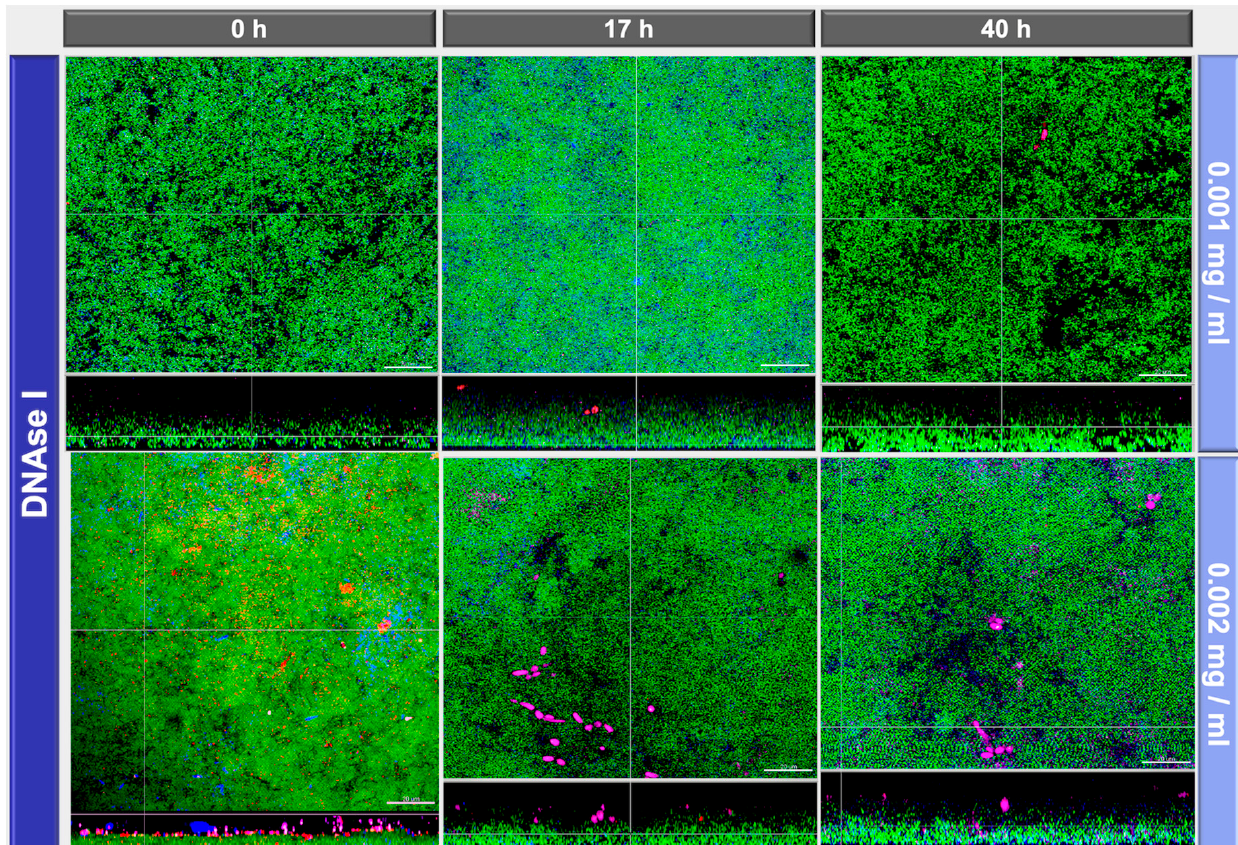
Figure 3. CLSM (confocal laser scanning microscopy) images show the multispecies biofilms after deoxyribonuclease I (DNase I) exposure at two concentrations (0.001 mg/mL, 0.002 mg/mL) and intervals (0 h, 17 h, 40 h). Bacteria are stained green (Yo Pro 1/Sytox Green DNA-staining), extracellular polymeric substances (EPS) blue (calcofluor), extracellular DNA appear red (anti-DNA antibodies and streptavidin, Cy3), and extracellular proteins magenta (SYPRO Ruby). The cross section shows the base of the biofilm base, which is directed towards the top view with a scale of 20 μ m.